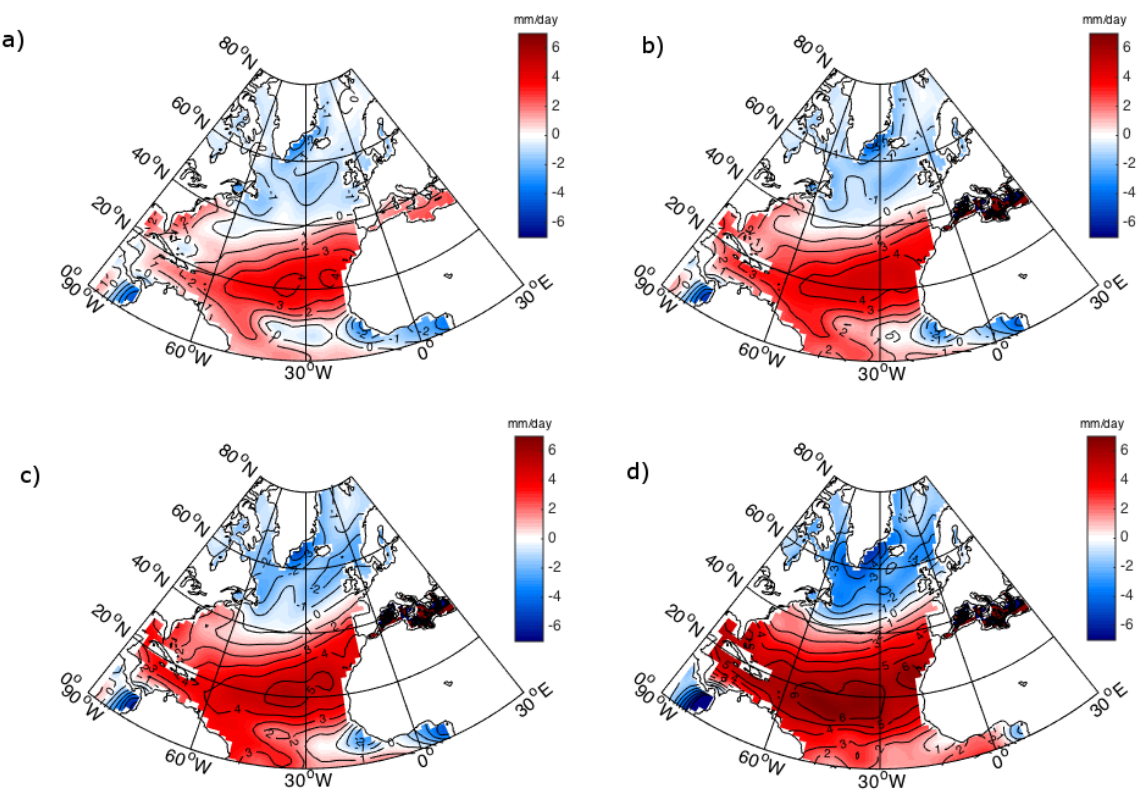
, (c) 8CO and (d) 16CO 2 2 2